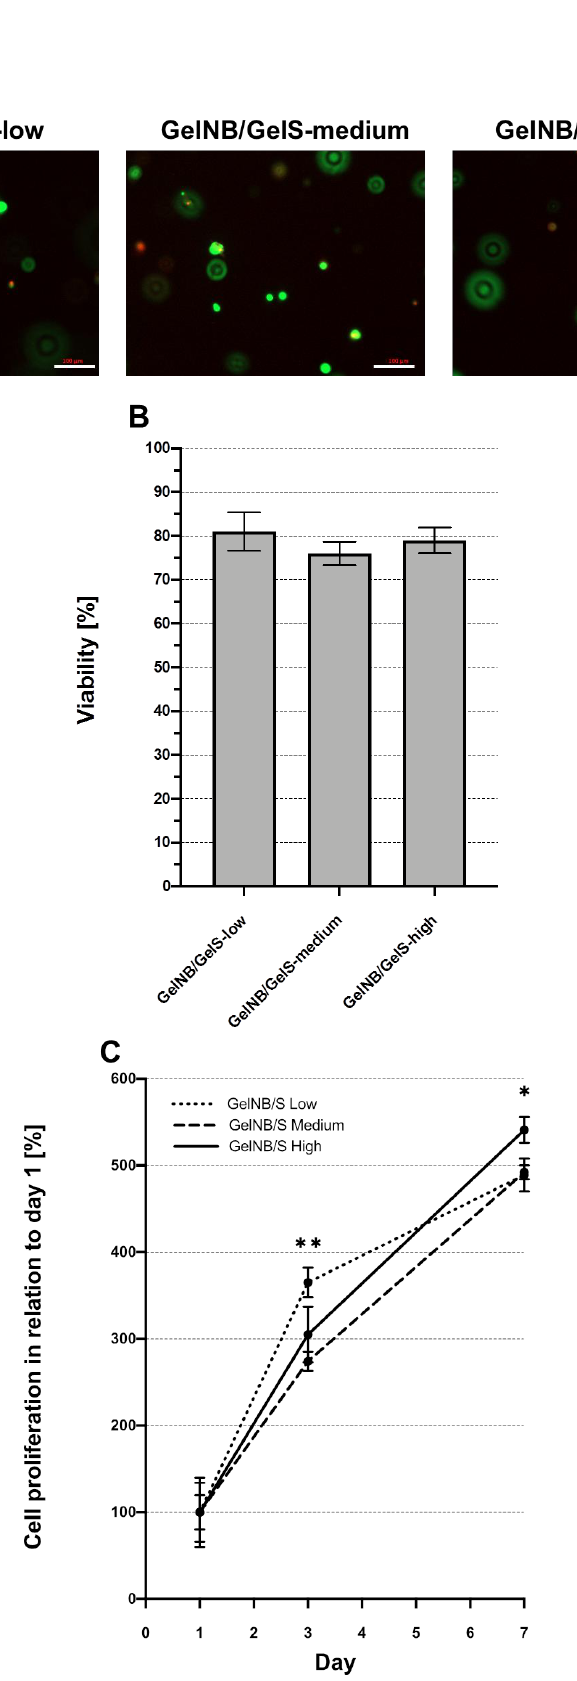
Figure 2. Viability and proliferation testing. ASCs were mixed into the three GelNB/GelS hydrogels. ( A ) Viability testing was performed using a live – dead assay and representative images are shown.